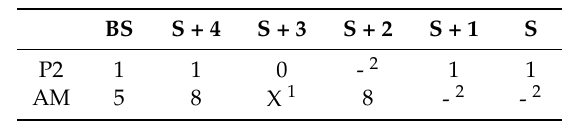
Table 2. Flags Bit Array—Pass II.